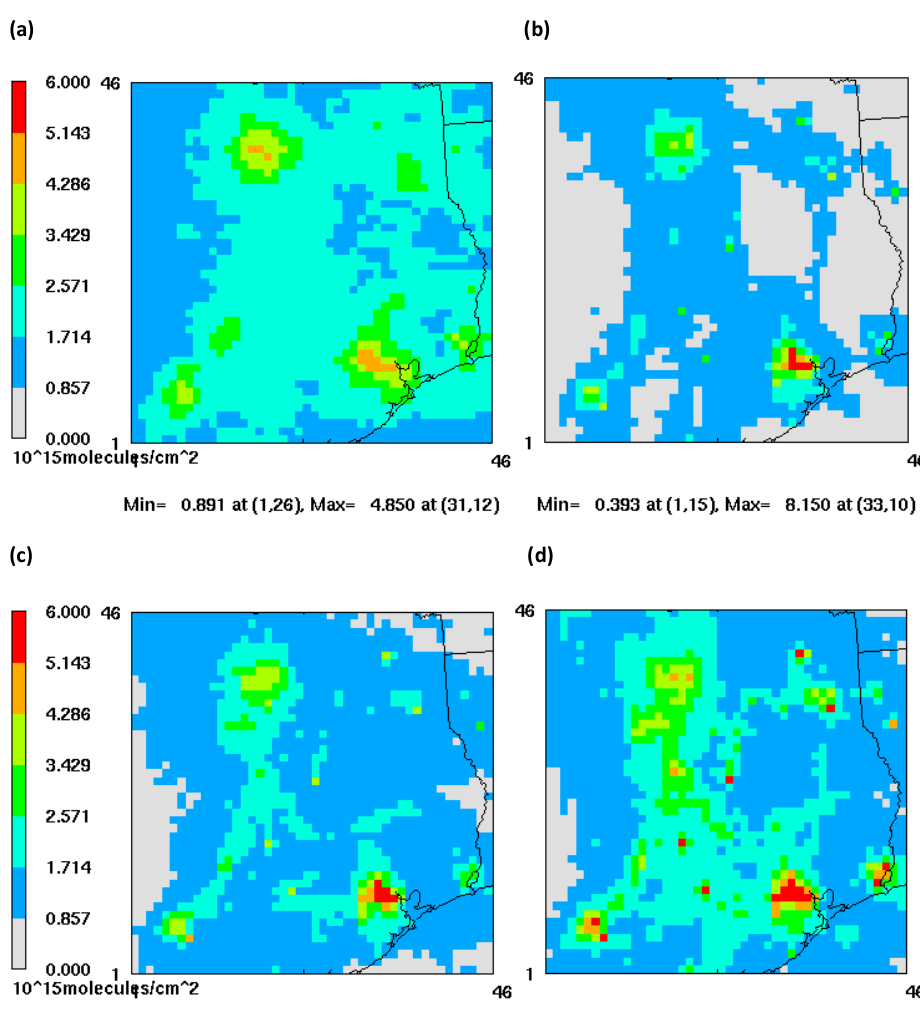
Fig. 4. Monthly averaged (3 June to 1 July) tropospheric NO 2 vertical columns at 13:00–14:00 from (a) OMI observations, and from CAMx simulations using (b) base case emission inventory, (c) a priori emission inventory (with additional lightning, aircraft, and soil NO x ), and OMI-based inverted NO x emissions using (d) the DKF